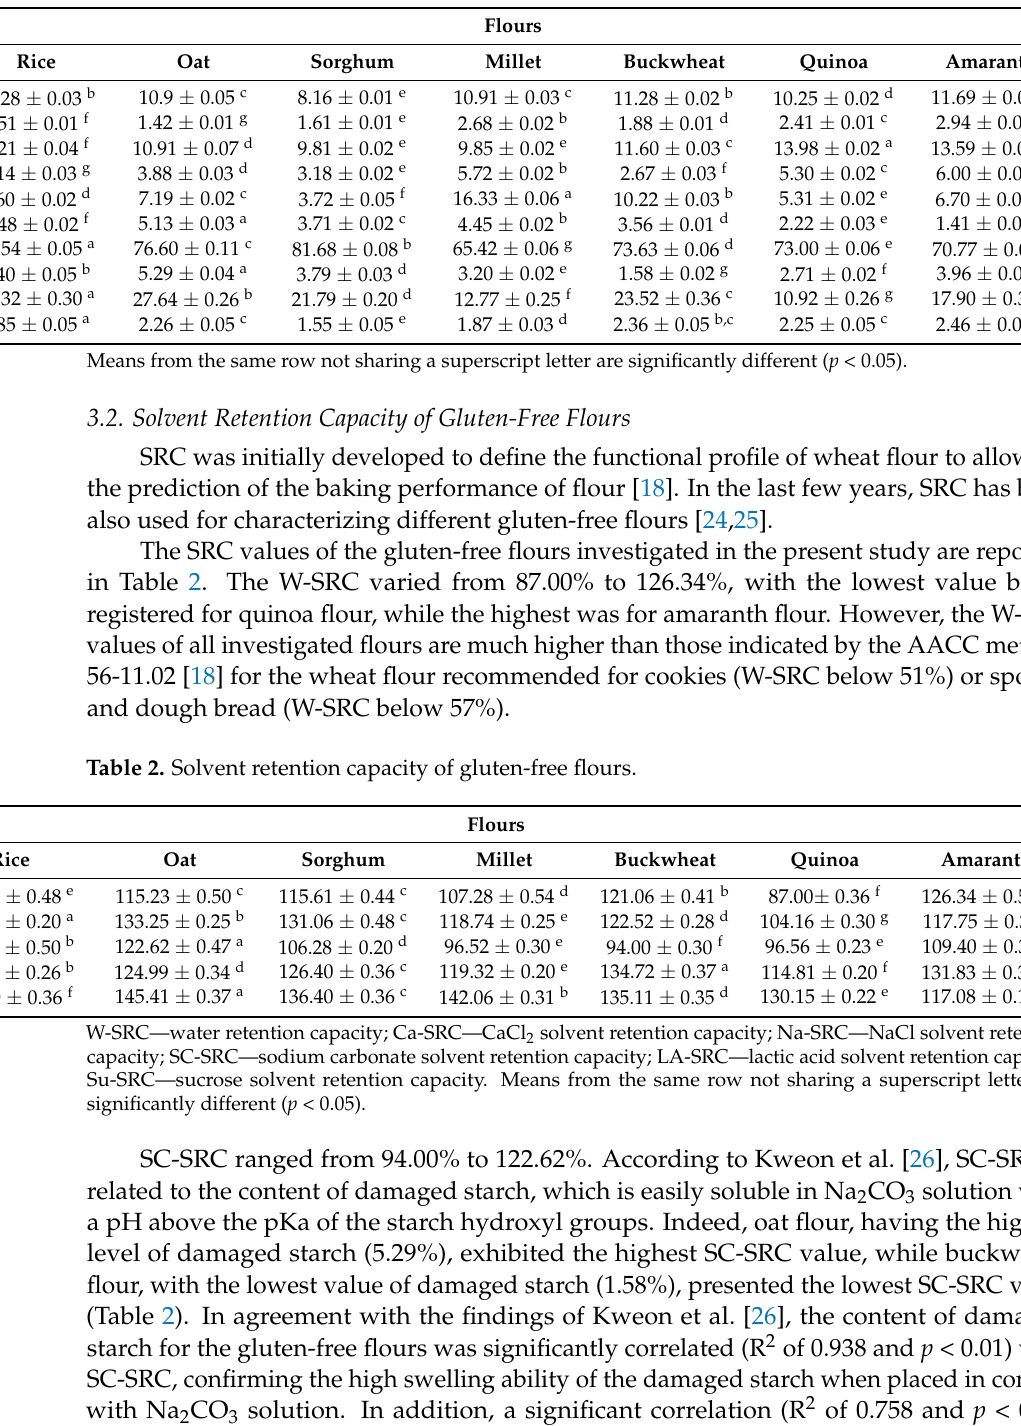
Table 1. Proximate compositions and fineness modules of the gluten free flours.